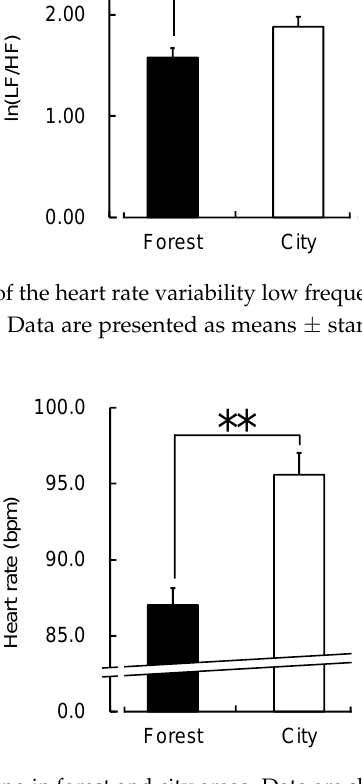
Figure 4. Heart rate during walking in forest and city areas. Data are shown as means ± standard error (n = 52). ** p < 0.01, paired t-test (one-sided). There were no significant differences in SBP or DBP between the forest and city areas (SBP after the forest walk: 97.3 ± 1.2 mmHg; SBP after the city walk: 97.5 ± 1.2 mmHg; p > 0.05; DBP after the forest walk: 59.8 ± 0.9 mmHg; DBP after the city walk: 59.2 ± 1.1 mmHg; p > 0.05). There were no significant differences in the blood pressure values before and after walking in either area. The pulse rate after walking differed significantly between the forest and city areas (forest: 69.3 ± 1.2 bpm; city: 71.9 ± 1.3 bpm; p < 0.05), although there was no significant difference before walking (forest: 67.9 ± 1.1 bpm, city: 69.4 ± 1.3 bpm; p > 0.05). The pulse rate increased between before and after walking in both areas.